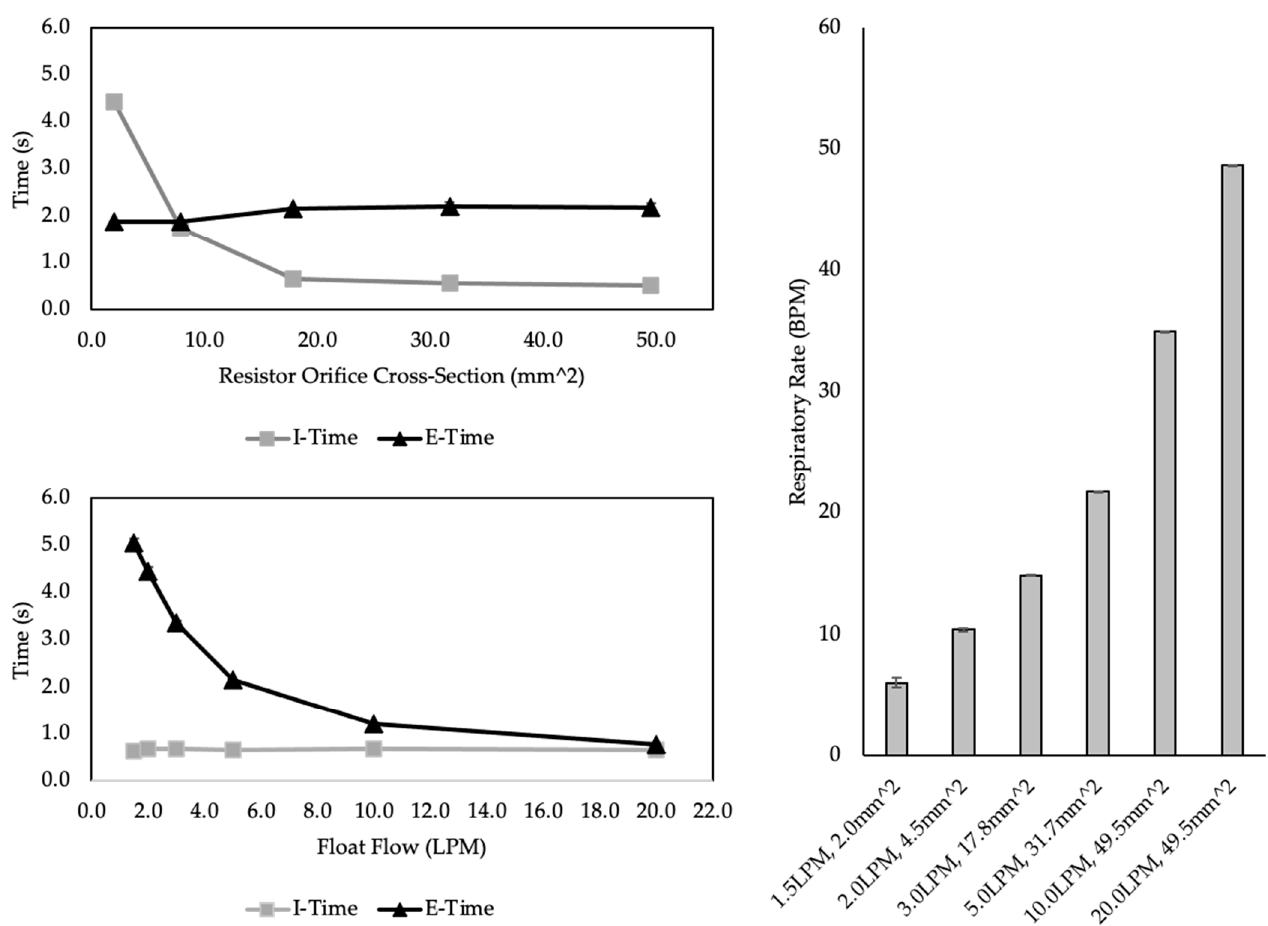
Figure 3. Outcomes of Part 1 of Test 1. The top left graph shows the trend of increasing float exhaust resistance on T I and T E . The bottom left graph shows the relationship between float flow and T I and T E . The graph to the right demonstrates how RR changes with changes in float exhaust resistance and float flow. All data points and bars are mean ± SD of 10 breaths. Lung model compliance was 55 mL/cmH 2 O, inspiratory and expiratory resistance was 12 cmH 2 O/L/min. Part two of Test 1 results are given in Table 2. The BVMS T I values consistently overshot the measured T I values recorded by the ASL 5000. The percent error between the set and measured T I ranged from − 1.6% to 35.3%. Only two T I settings were within the 5% acceptable error rate. The BVMS RR values were much closer to the measured RR values. Percent error values ranged from − 5.7% to 8.7%, and all but two settings fell outside the 5% acceptance criteria. Wave tracings are shown in Figure 3, which illustrates how the